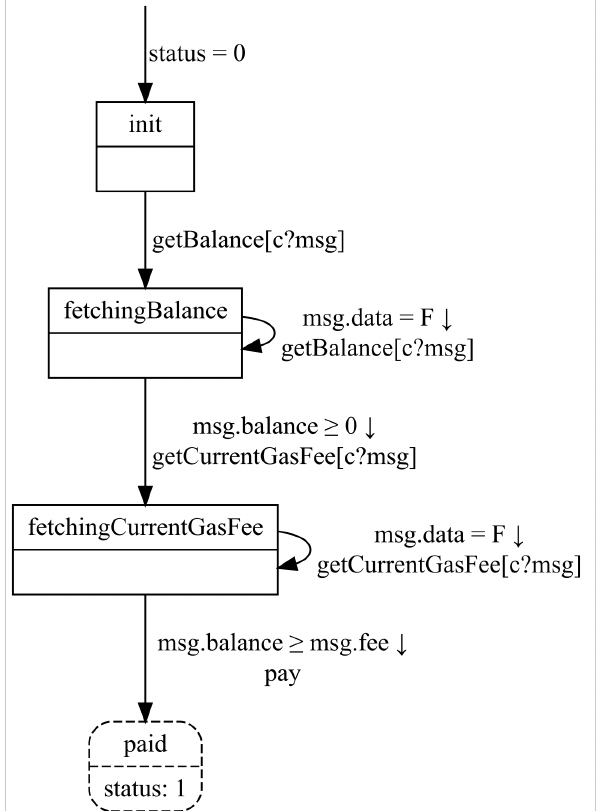
Figure 4. A visualized increment integrated in the system graph of the transaction client in Example